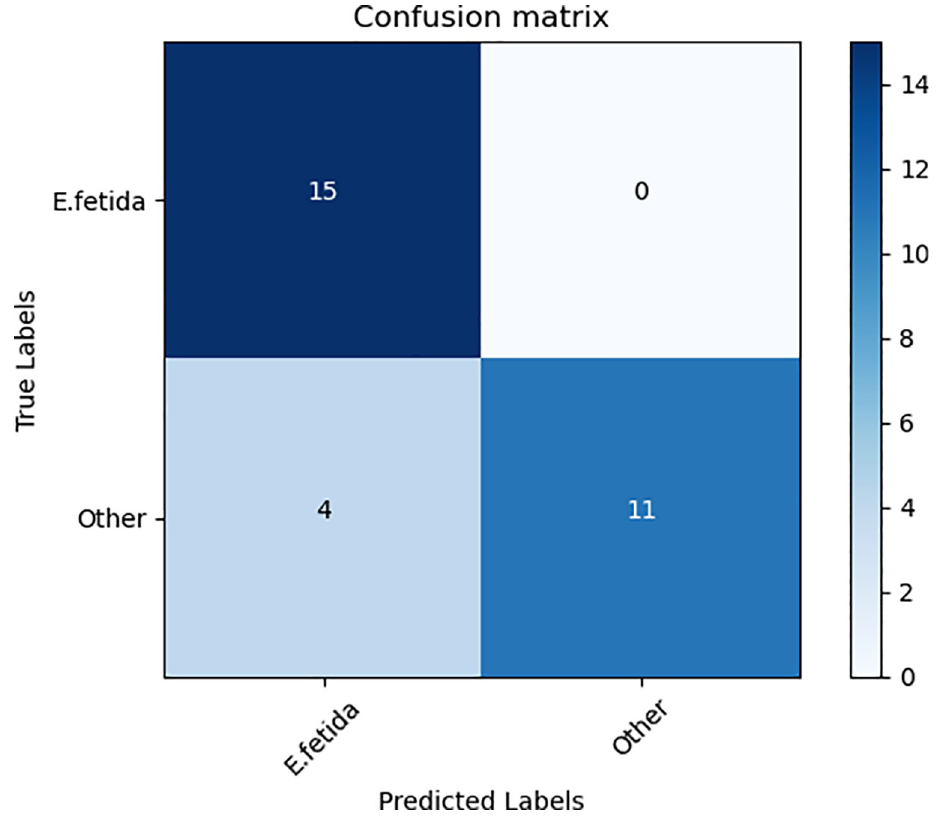
Fig 4. Confusion matrices: Showing the performance of our proposed model for earthworm species identification in a real setting under the supervision of a qualified taxonomist.